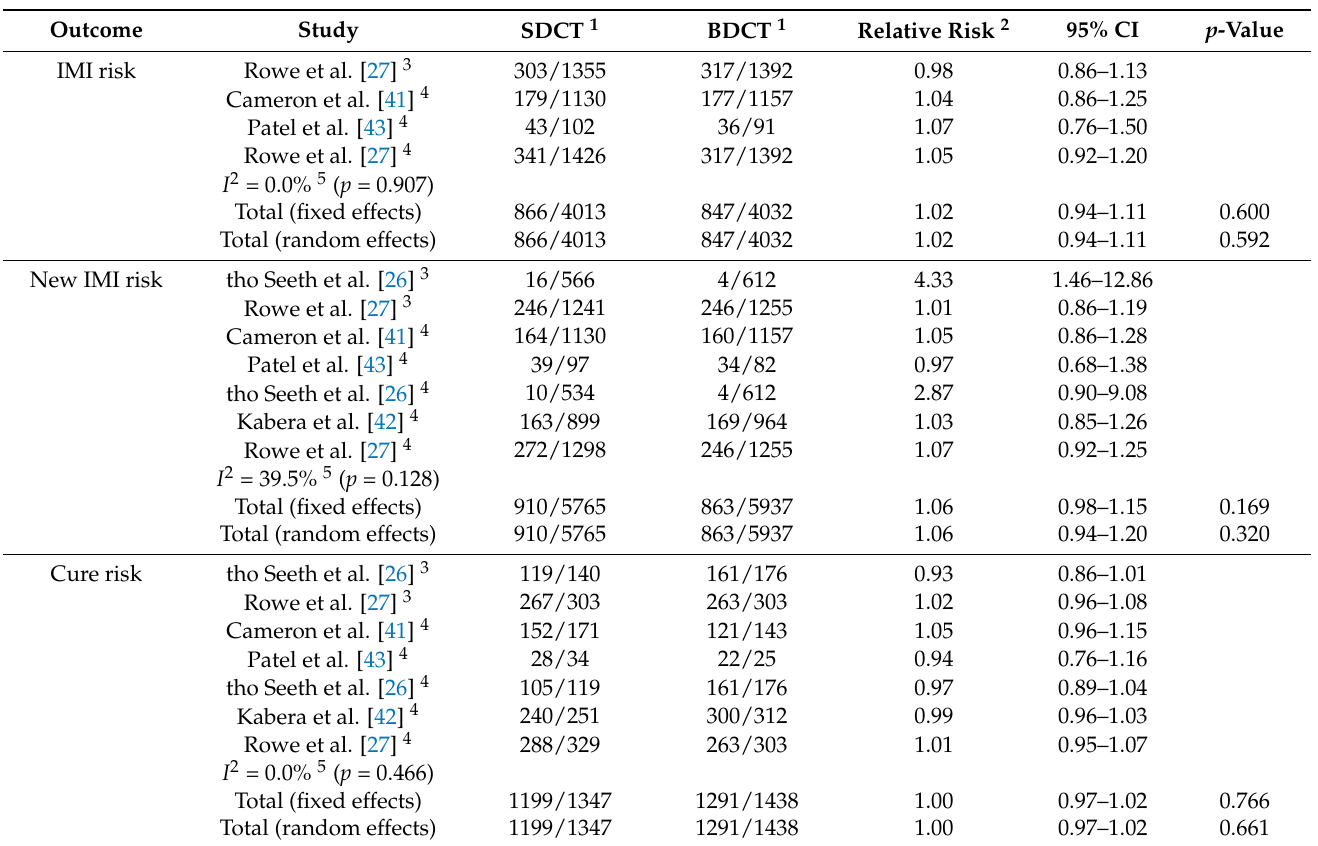
Table 3. Effect of selective compared to blanket dry cow treatment on intramammary infection (IMI) risk after calving, new IMI risk after calving, and cure risk during the dry